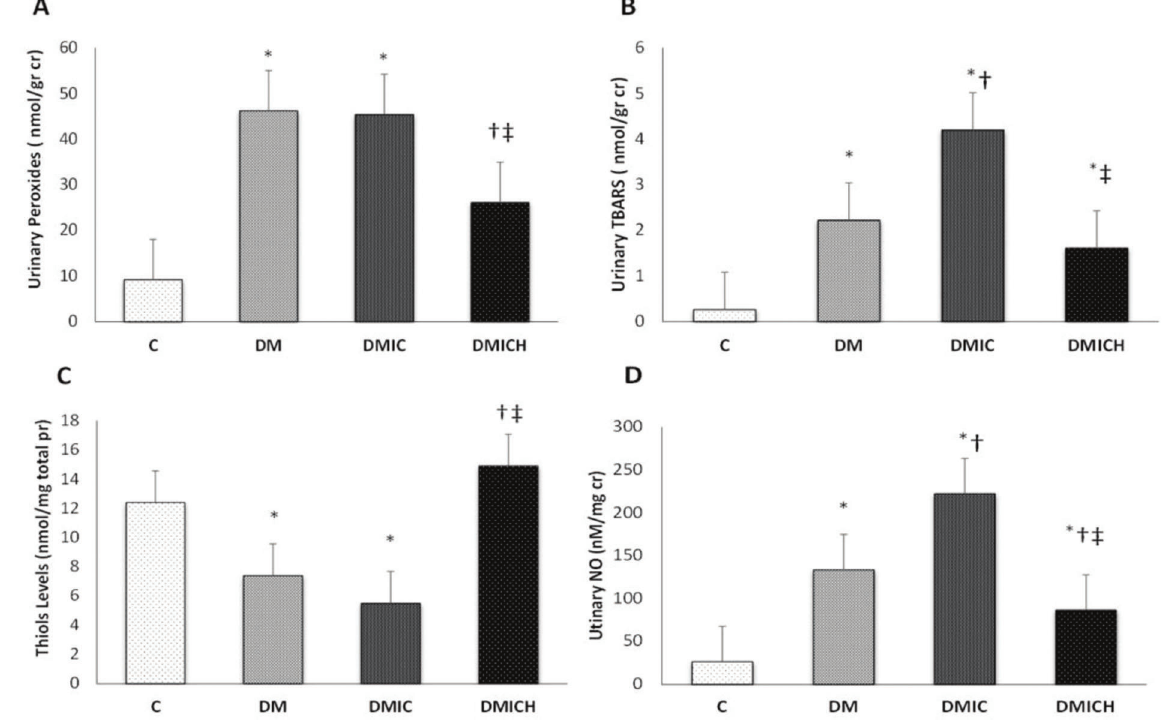
Figure 1 - Oxidative and nitrosative profiles of the rats from the control and diabetic groups. (A) Urinary peroxide levels (nmol/g cr), (B) urinary TBARS levels (nmol/g cr), (C) thiol levels (nmol/mg total pr), and (D) urinary NO levels (nM/mg cr). Cr: creatinine. Pr: protein. NO: nitric oxide. Data are shown as the mean ± SEM for each group (n=7). Statistical significance was set at p o 0.05. * p o 0.05 versus C, w p o 0.05 versus DM, = p o 0.05 versus DMIC.